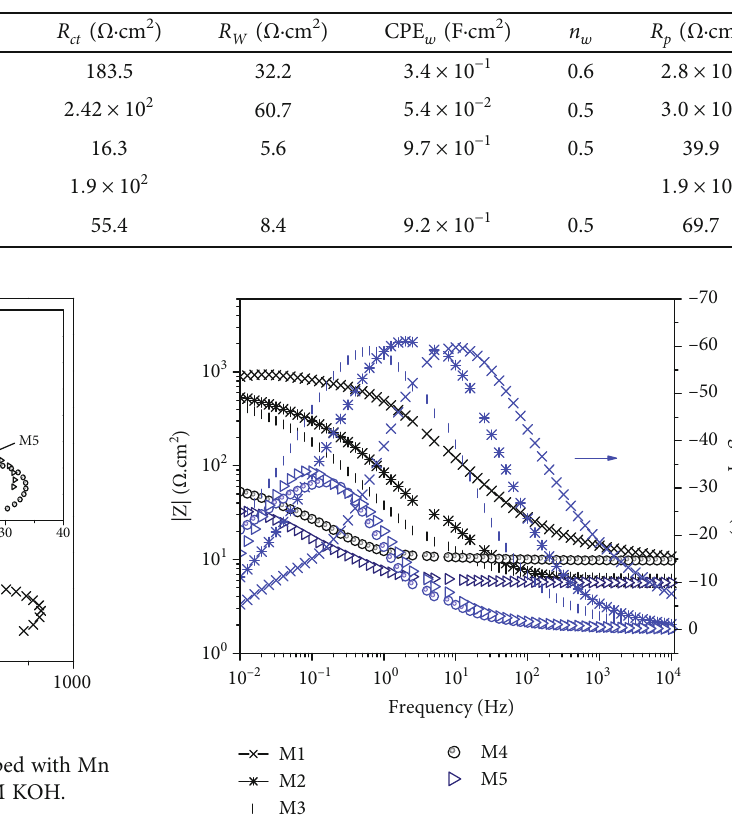
Figure 3: Equivalent circuits to fi t the EIS results for the Al-based alloy doped with Mn and Co as cast and with heat treatments. Table 2: Impedance parameters obtained through the equivalent circuit for aluminum-based alloy doped with Mn and Co as cast, immersed in 3M KOH.